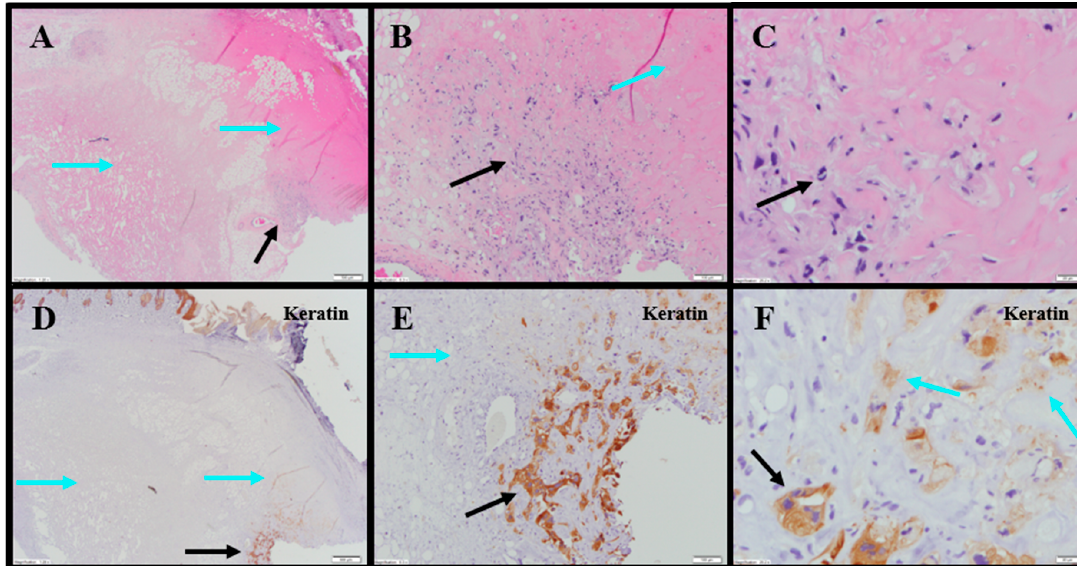
Figure 5. Representative photomicrographs of renal tumors administered 2 × IT NanoDoce ® . ( A ) Extensive skin ulceration (top right) above extensive necrotic material (blue arrows) and a 0.9 mm residual focus of viable carcinoma (black arrow) 2 × . ( B ) Viable TCs with retained nuclei (black arrow). A progressive loss of viable TCs toward the upper right corner (blue arrow) 10 × . ( C ) The leading edge of the viable tumor (black arrow) and the adjacent zone of TC death. Remnants of TCs (from bottom left (black arrow) to top right) in progressive stages of death, evidenced by loss of nuclei and discrete cytoplasmic membranes 40 × . ( D ) Anti-AE1 / AE3 reveals focus of residual viable carcinoma (black arrow) surrounded by an extensive unstained (necrotic) area (blue arrows). Discrete staining of normal epidermis seen at top left 2 × . ( E ) Viable nucleated TCs strongly labeled with anti-AE1 / AE3 (black arrow) surrounded by unstained necrotic tissue (blue arrow) 10 × . ( F ) Progressive transition from viable, nucleated, keratin-positive TCs (black arrow) to TCs in varying stages of necrosis (blue arrows) 40 × .